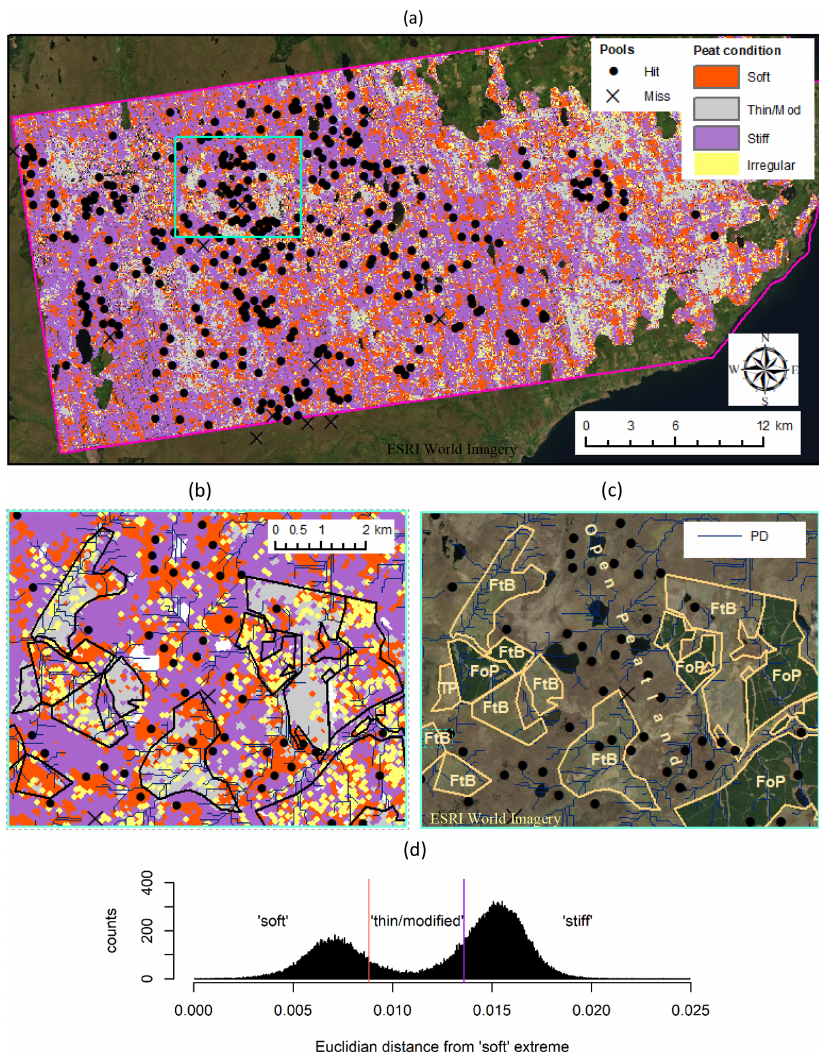
Figure 8. The ecohydrological classification of “soft”, “thin/modified”, and “stiff” peatland condition, with respect to the location of pool systems, and areas of forest-to-bog restoration in the study area. (a) Classified map based on the Euclidian distance (in three-dimensional Cartesian space) from the position of the soft reference to all other points in the three-axis plot of peak timing, amplitude, and multi-annual average velocity, including the screened irregular time series for the period 10 May 2016 to 9 May 2017. Pool systems that have been correctly classified are shown as a “hit” and otherwise as a “miss”. (b) A detailed view of the classified area highlighted within (a) illustrating the relationship with hydrology, determined from a DEM (potential drainage, PD) and polygons delineating areas for restoration. (c) A true colour satellite image of area showing the restoration status of the polygons, un-felled forest on peat (FoP), peat areas at various stages or different years of forest-to-bog (FtB) restoration, and an area of thin peat (TP). (d) Frequency distribution of Euclidian distance, and the thresholds used to differentiate between the three peat conditions. Credits: the classified area (approx. 930km 2 ) was delineated using peat soils from the National Soil Map of Scotland (JHI, 2021). Images sourced via Esri ArcMap in 2021. Image source for (a) and (c) Esri World Imagery: Esri, DigitalGlobe, GeoEye, i-cubed, USDA FSA, USGS, AEX, Getmapping, Aerogrid, IGN, IGP, swisstopo, and the GIS User